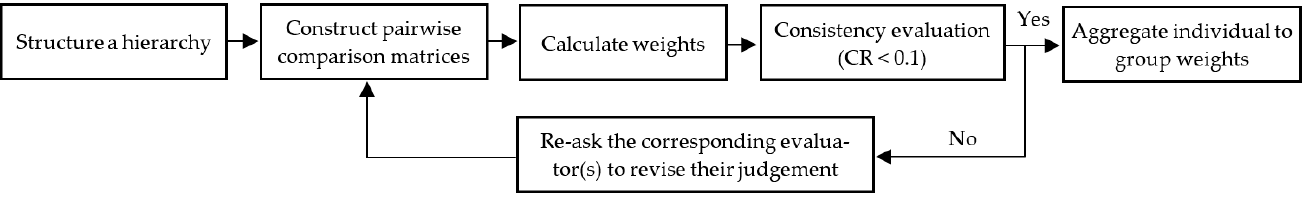
Figure 3. Main steps used in